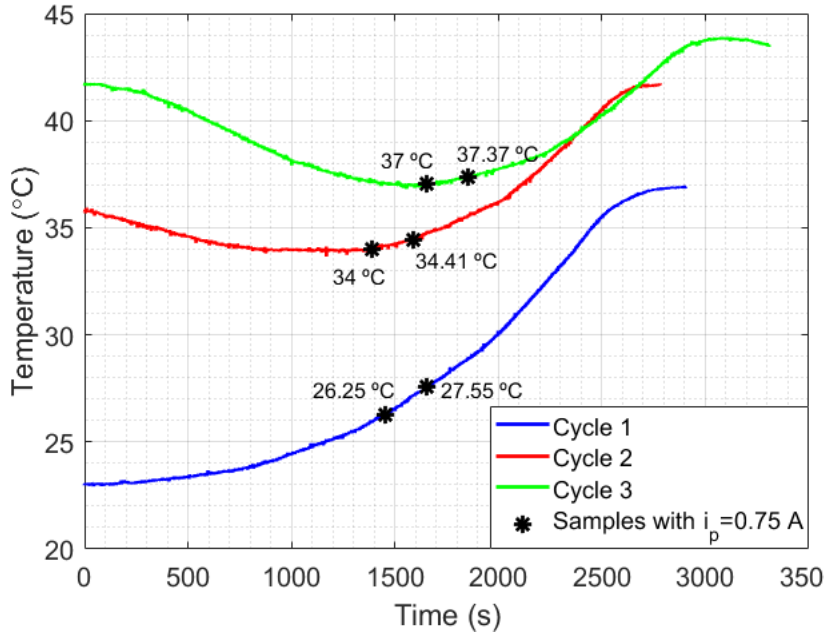
Figure 7. Curves for the temperature relative to time, measured in mineral oil in order to evaluate the impact of different initial temperatures of the liquid (which implies different setup